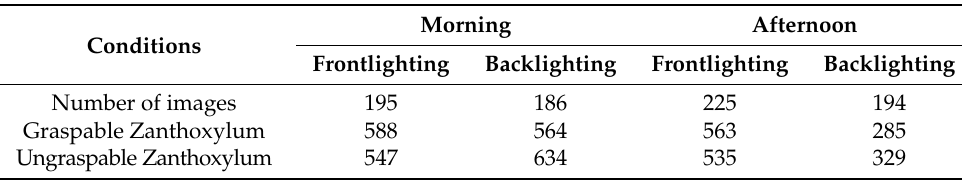
Table 1. Sample analysis details of text set